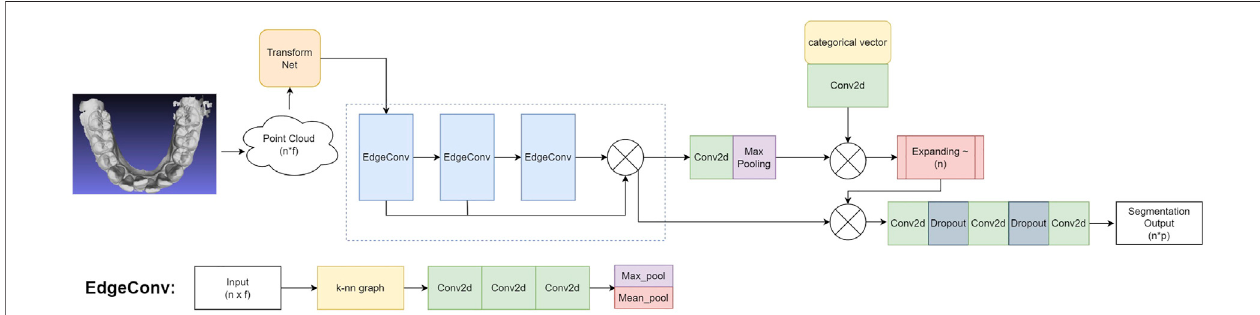
FIGURE2| Thearchitectureofour3Dtoothsegmentationnetwork:Inputmesh → Pointcloud x ∈ R n × f → Transformnet → EdgeConv → EdgeConv → EdgeConv → Conv2D[1024] → Maxpool → Conv2D[256] → Dropout → Conv2D[256] → Dropout → Conv2D[128] → Output. n denotesthenumberofsamplepoints,and f denotes the number of features. In our implementation we set n = 10, 000 and f = 15. The segmentation output y ∈ R n × p gives pointwise prediction for p semantic labels. ⊗ represents concatenation. Conv2D[64] denotes a 2D convolutional layer with 64 fi lters.